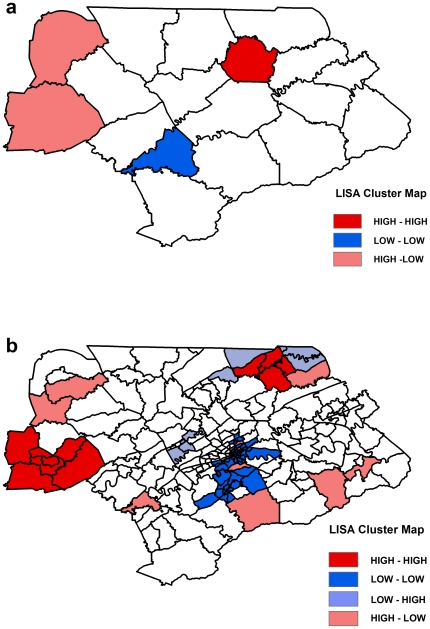
The spatial clustering of La Crosse virus infections at the county and census tract levels.These maps show the significant clustering of La Crosse virus infections for the population 18 years and younger at the county level (a) and at the census tract level (b) detected by the Local Indicators of Spatial Autocorrelation (LISA) statistic for eastern Tennessee.